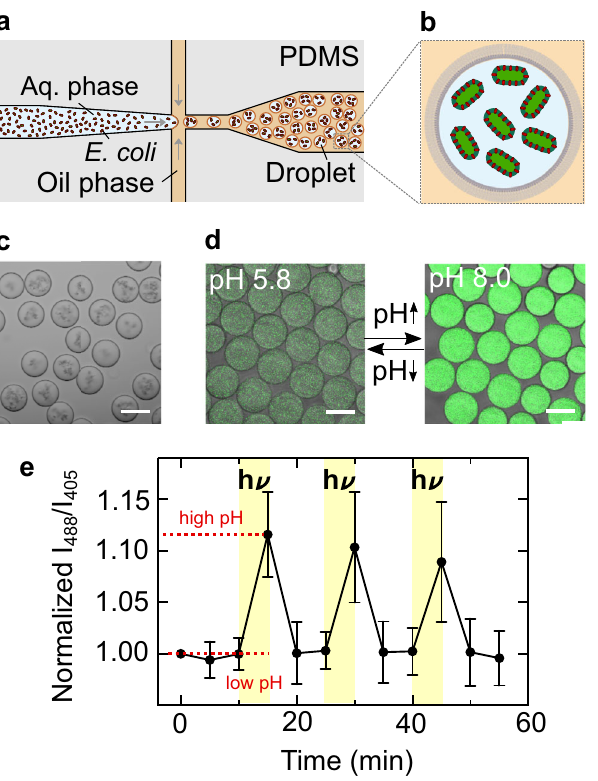
Fig. 2 E. coli as light-activated synthetic organelles that change the pH inside cell-sized con fi nement. a Schematic illustration of the micro fl uidic device used to encapsulate engineered E. coli and pyranine into cell-sized compartments. Water-in-oil droplets were generated at a fl ow-focusing T-junction of a PDMS-based device. b Schematic illustration of a surfactant- stabilized water-in-oil droplet containing engineered E. coli . c Bright fi eld image of monodisperse water-in-oil droplets with a radius of 27 ± 5 μ m (mean ± s.d., n = 53) containing engineered E. coli (OD 600 = 20). Scale bar: 50 μ m. d Overlay of confocal fl uorescence and bright fi eld images of pyranine (c = 50 μ M, λ ex = 488 nm) inside droplet-based compartments at pH 5.8 and pH 8.0. Scale bar: 50 μ m. e Normalized fl uorescence intensity ratio I 488 /I 405 of E. coli and pyranine-containing droplets over time. The fl uorescence intensity ratio (mean ± s.d., n = 11 droplets) of pyranine (and hence the pH) increases reversibly during periods of illumination with white light (30 W halogen bulb, highlighted in yellow). Note that the number of recorded frames was reduced because the illumination light had to be turned off each time an image was acquired, which will bias the proton pumping activity. Source data is available for Fig. 2e.